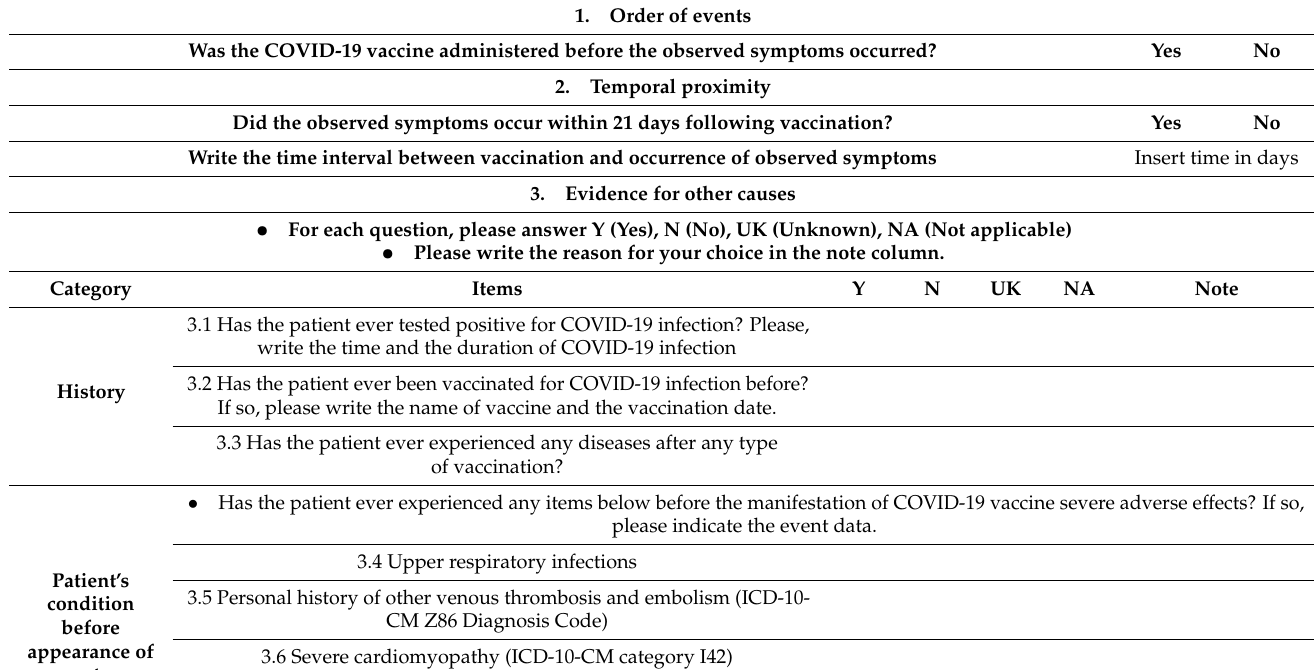
Table 1. Causality assessment guidelines for AEFI following COVID-19 vaccine administration: